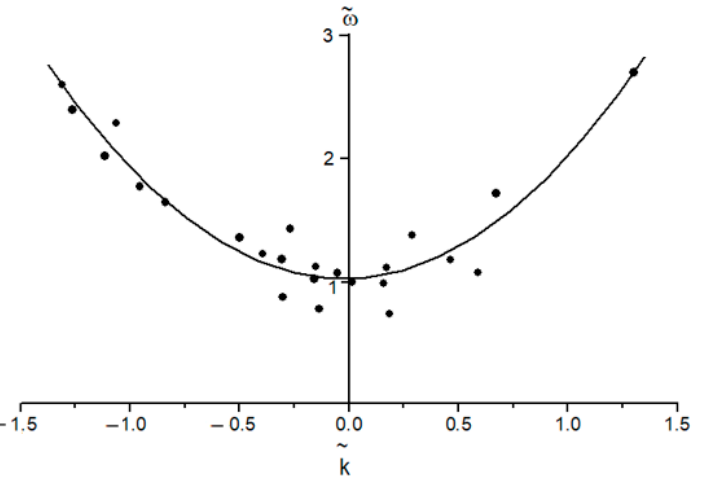
Figure 3. The distribution of local elongations ε xx , observed for the sample midline, and the X − t diagrams for measuring λ and T values.